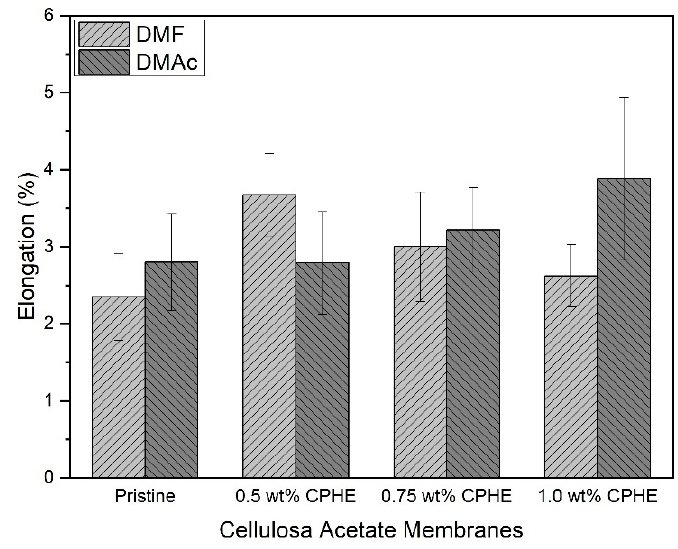
Figure 7 . Elongation of the membrane sheets. Figure 7. Elongation of the membrane